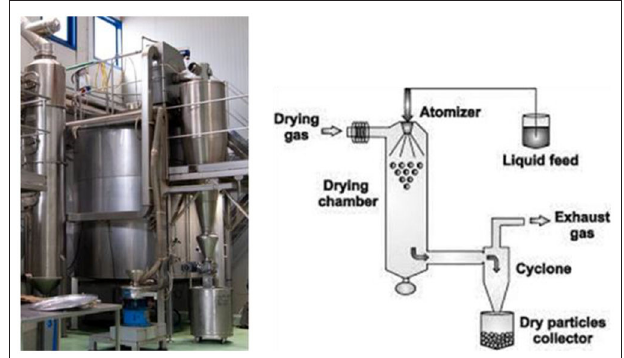
FIGURE 1 | Spray drier system utilized to dry olive mill wastewater (OMWW).